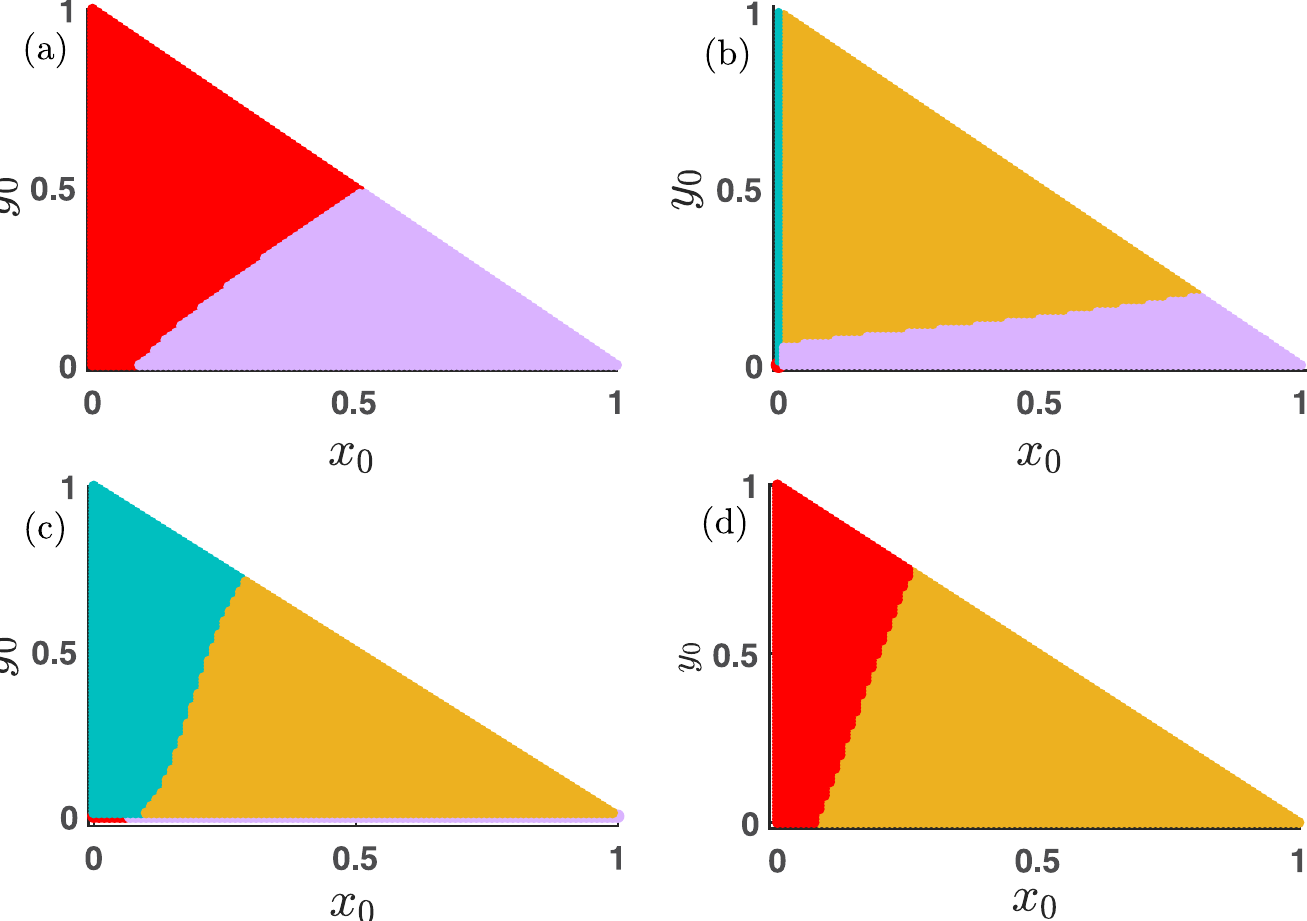
Fig 1. Alternations between multiple co-existing steady states depending on initial conditions. The coexistence of various stable states is portrayed here by varying the initial conditions maintaining 0 � ( x 0 + y 0 ) � 1. Red points signify the extinction equilibrium E 0 . Violet points represent the defector-free steady state E 1 . The cooperator-free stationary points E 2 are shown by sea blue points, and the coexistence equilibrium E 3 is plotted using yellow points. The mutation-free model in subfigures (a-c) allows four stable steady states to coexist. However, subfigure (d) supports only bistability for the chosen parameters’ values. The parameter values for each of these subfigures are (a) ξ = 0.38, β = 1.1, p = 0.30, σ 1 = 0.36, σ 2 = 0.25, and μ = 0. (b) ξ = 0.15, β = 1.06, p = 0.69, σ 1 = 0.75, σ 2 = 0.25, and μ = 0. (c) ξ = 0.15, β = 1.1, p = 0.10, σ 1 = 0.10, σ 2 = 0.25, and μ = 0. (d) ξ = 0.30, p = 0.30, β = 1.1, μ = 0.02, σ 1 = 0.30, and σ 2 = 0.20. Other parameter is η =